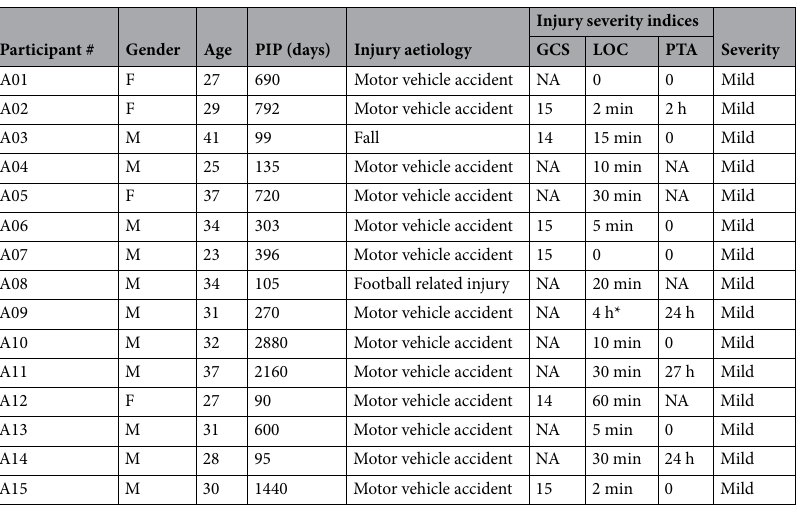
Table 2. Injury characteristics of patients with mild TBI. PIP Post-injury period, GCS Glasgow Coma Scale, LOC duration of loss of consciousness, PTA duration of post-traumatic amnesia, min minutes, NA no data available. *Normally LOC duration is less than 30 min, but the diagnosis of TBI for this patient was made by a physician.